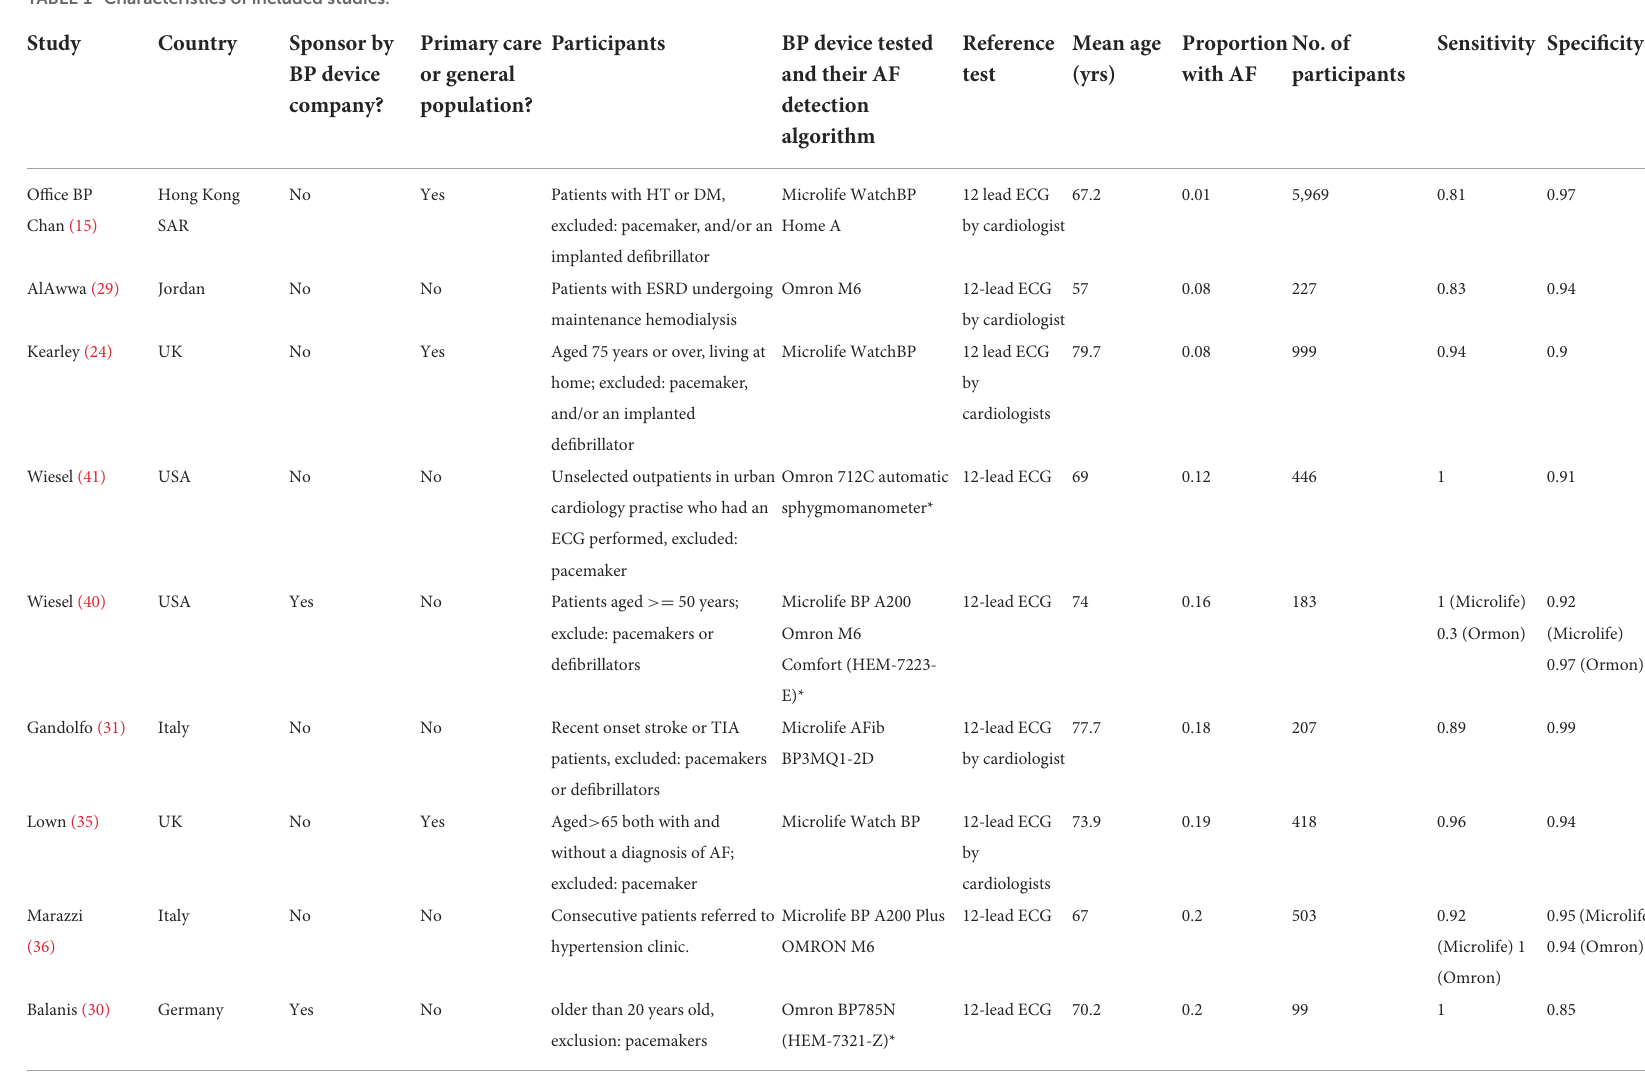
TABLE 1 Characteristics of included